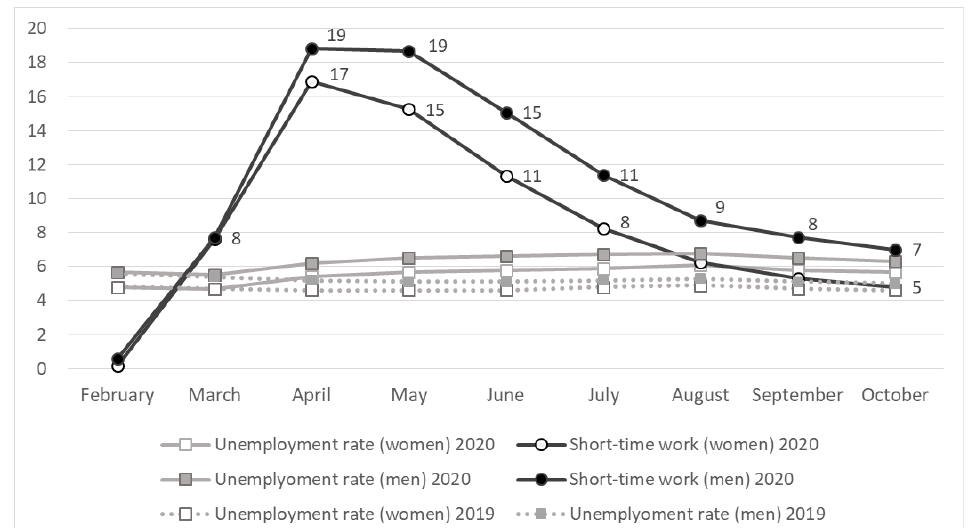
Source: Statistik der Bundesagentur für Arbeit (2021); Statistisches Bundesamt